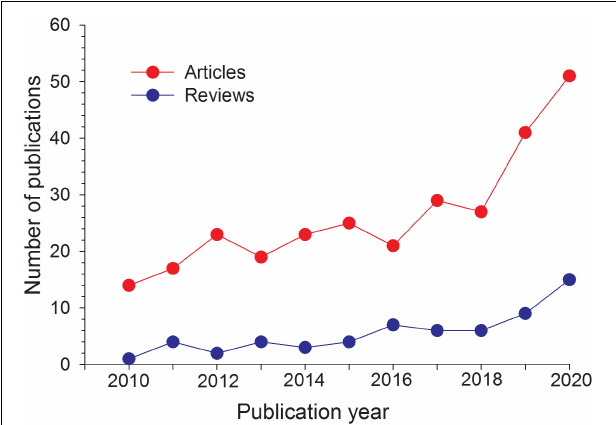
FIGURE 1 | Number of publications related to silicon in plants from 2010 to 2020, based on Scopus search with the title words: “Silicon” or “Silicate” and “Plants,” refined to “Agricultural and Biological Sciences” (March, 2021). Total number of publications: 351; research articles: 290; reviews: